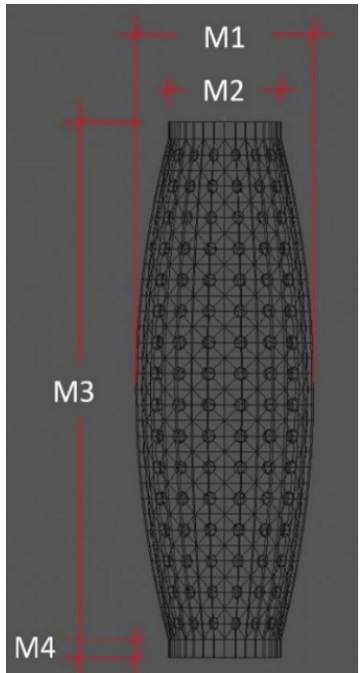
Figure 2. Test Sleeve design.